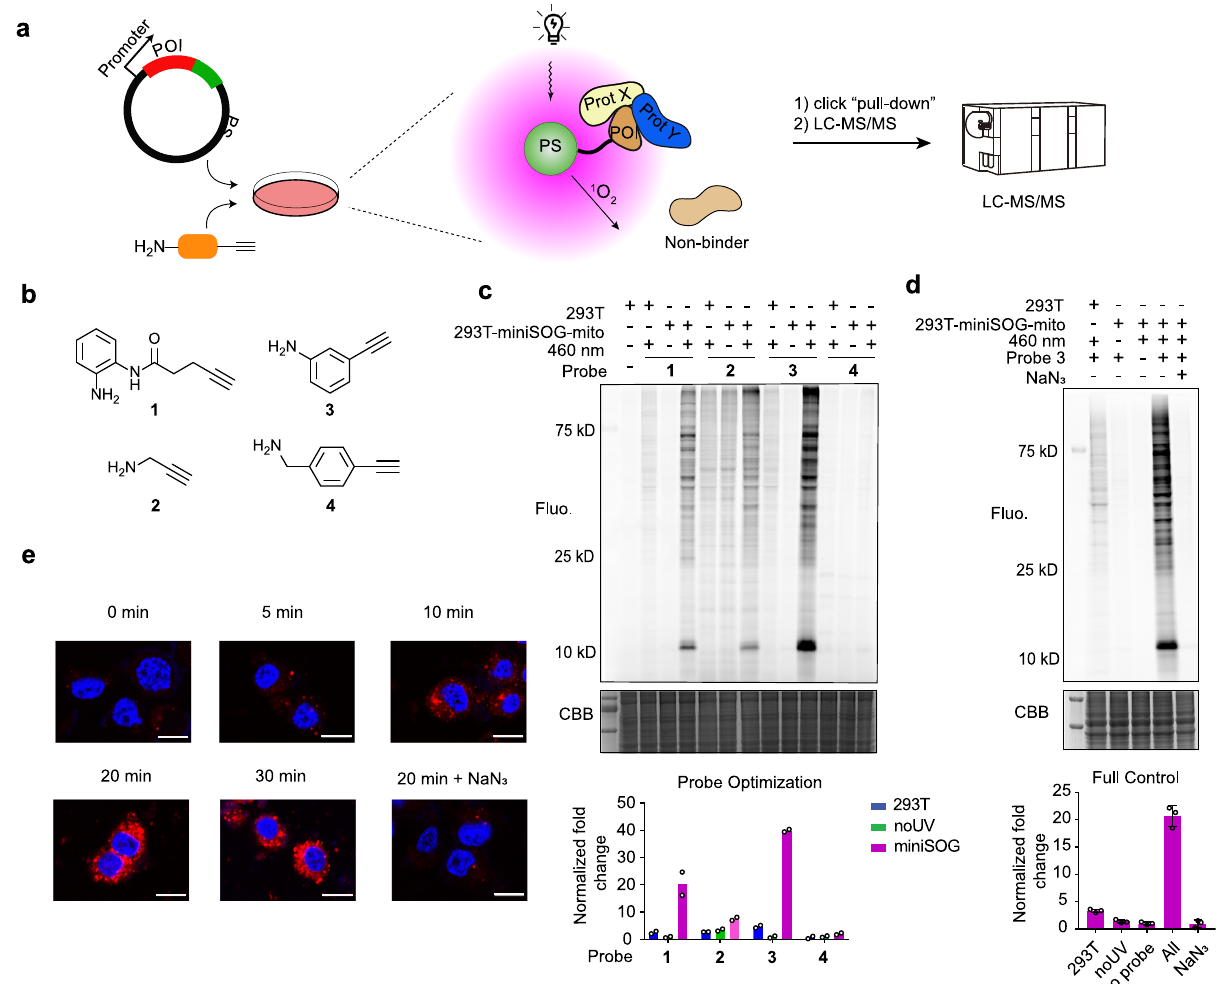
Fig. 1 | Development and characterization of photoactivation-dependent proximity labeling method. a Schematic of miniSOG-mediated protein complex labeling. On blue light illumination, miniSOG-POI-expressing cells generate singlet oxygen, which modi fi es interacting proteins rather than non-binder proteins. The photo-oxidation intermediate is intercepted by amine chemical probe relay label- ing to form a covalent adduct. The alkyne group on the chemical probe enables click chemistry for pull-down enrichment, followed by quantitative analysis by LC- MS/MS. b Thechemicalstructureofamineprobes 1-4 . c Representative fl uorescent gel analysis of mitochondria-localized miniSOG-mediated proteomic labeling with probes 1-4 aswellastherelativequanti fi cationbasedongeldensitometry.Negative